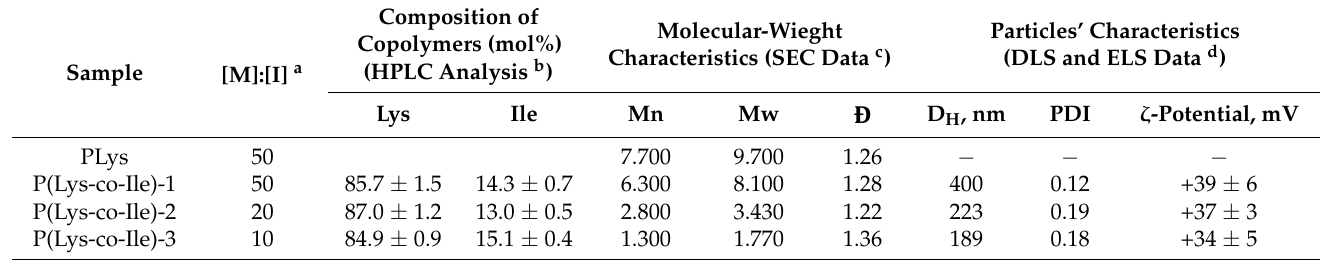
Table 1. Composition and molecular-weight characteristics of synthesized polypeptides and characteristics of particles obtained from such copolymers. Lys(Z)/Ile ratio was 80/20 for all samples in this Table. For other ratios please see Table S1 in Supplementary Materials.